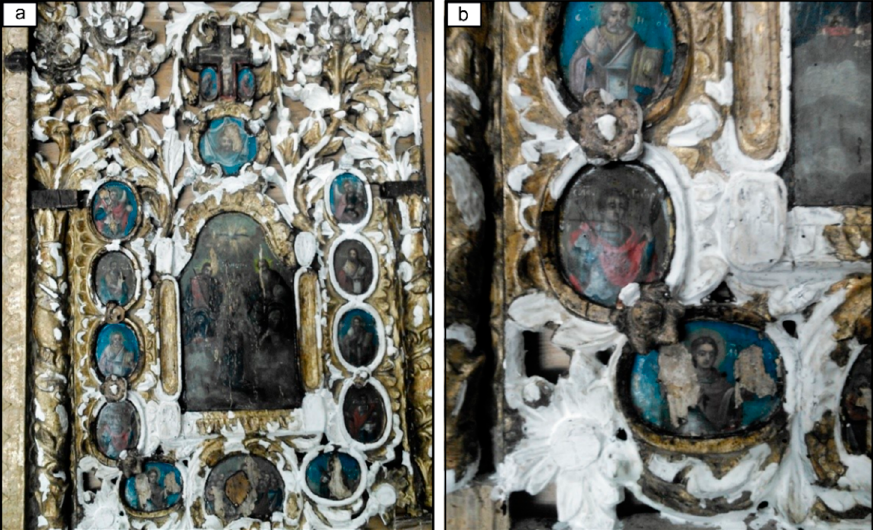
Figure 15. The final filling: ( a ) overall appearance; ( b ) detail.